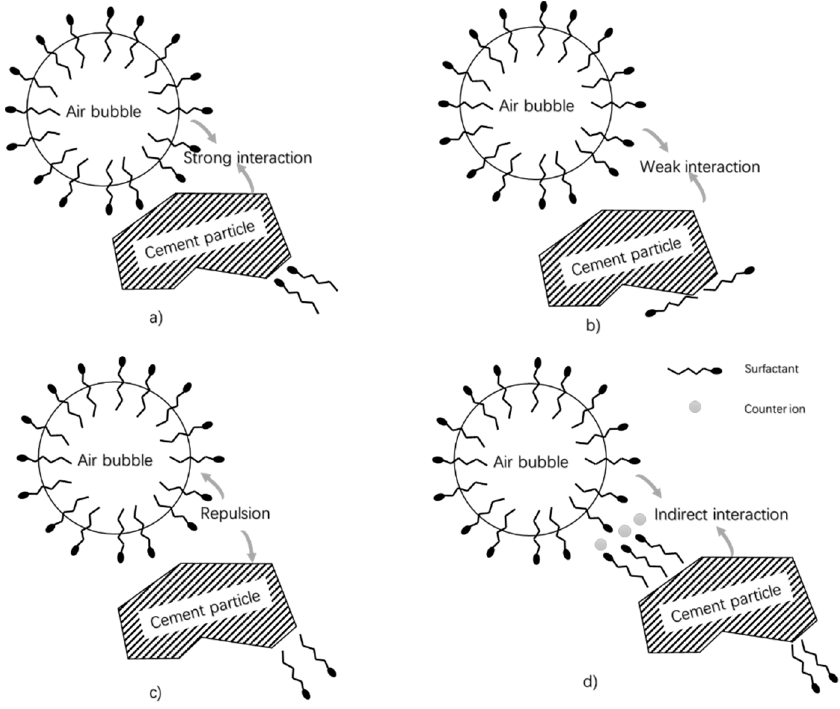
Figure 8. Schematic illustration of the influence of the surfactant’s orientation on the interaction between air bubble and solid particle: ( a ) strong interaction; ( b ) weak interaction; ( c ) repulsion; and ( d ) indirect interaction.